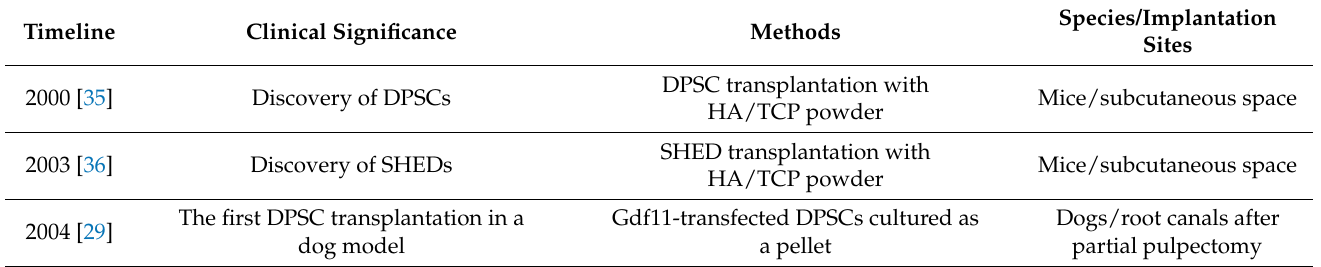
Table 3. DPSC- and SHED-mediated pulp regeneration from the bench to the